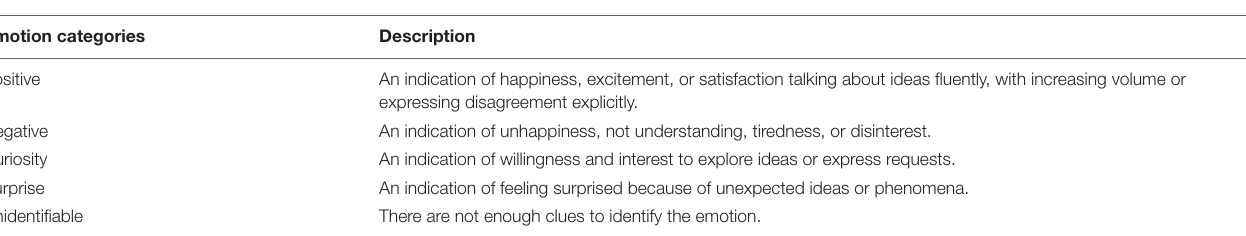
TABLE 2 | The categories and descriptions of emotion coding scheme.